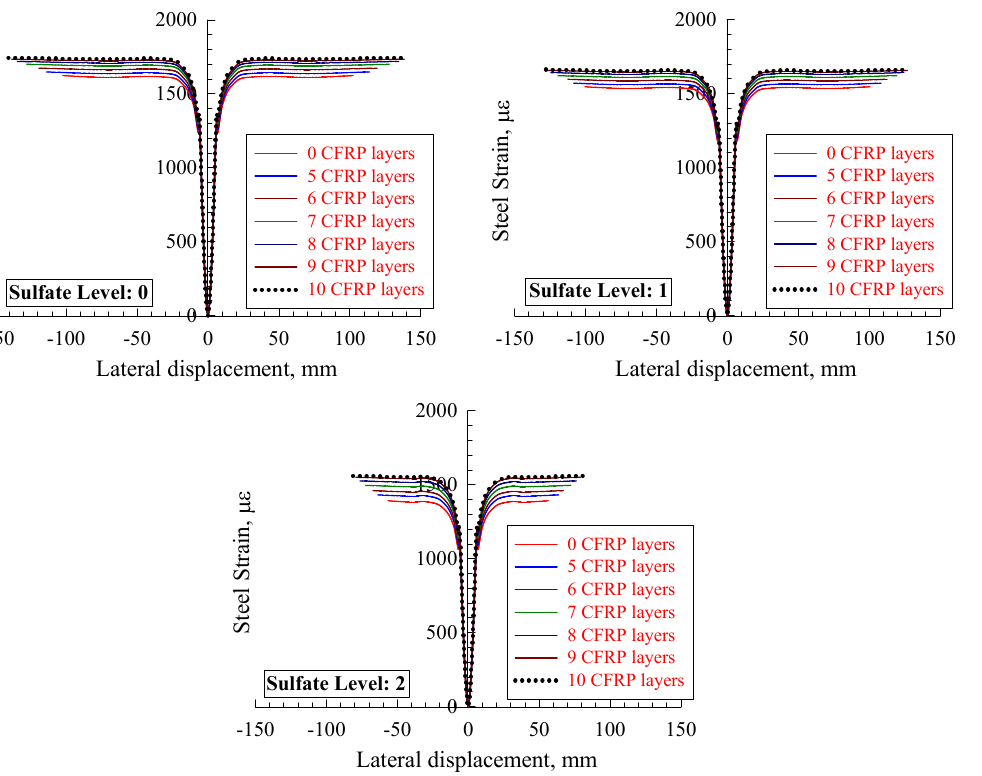
Figure 12. Steel strain versus lateral displacement of CFT columns. It must be noted that the strain of the reinforcing steel tube was modified as per the strain of yielding in order to highlight the influence of the study parameters on steel strain, as demonstrated in Figure 13. It is revealed from Figure 13 that, at level 0 of sulfate, the strain of the steel tube enhanced by 21%, 23%, 25%, 27%, 29%, 30%, and 30% for zero, five, six, seven, eight, nine, and ten layers, respectively, of CFRP. When exposing the specimens to sulfate level 1, the steel tube’s enhanced by 10%, 14%, 14%, 15%, 16%, 18%, and 18% when using zero, five, six, seven, eight, nine, and ten layers of CFRP, respectively. Addi- tionally, at sulfate level 2, the results show that the steel tube’s strain increased by 1%, 4%, 6%, 8%, 10%, 12%, and 13% when using zero, five, six, seven, eight, nine, and ten layers of CFRP, respectively. The findings show that the specimens exposed to level 2 of sulfate had the least enhancement in the steel tube’s strain when the CFRP layers were increased. In addition, it has been found that the strain of the steel tube increased in a proportional manner when the number of CFRP layers was raised up to eight layers, whereas increas- ing the number of layers to nine or ten had no significant effect. Hence, it can be concluded that using eight CFRP layers is the most efficient at enhancing the models’ performance.